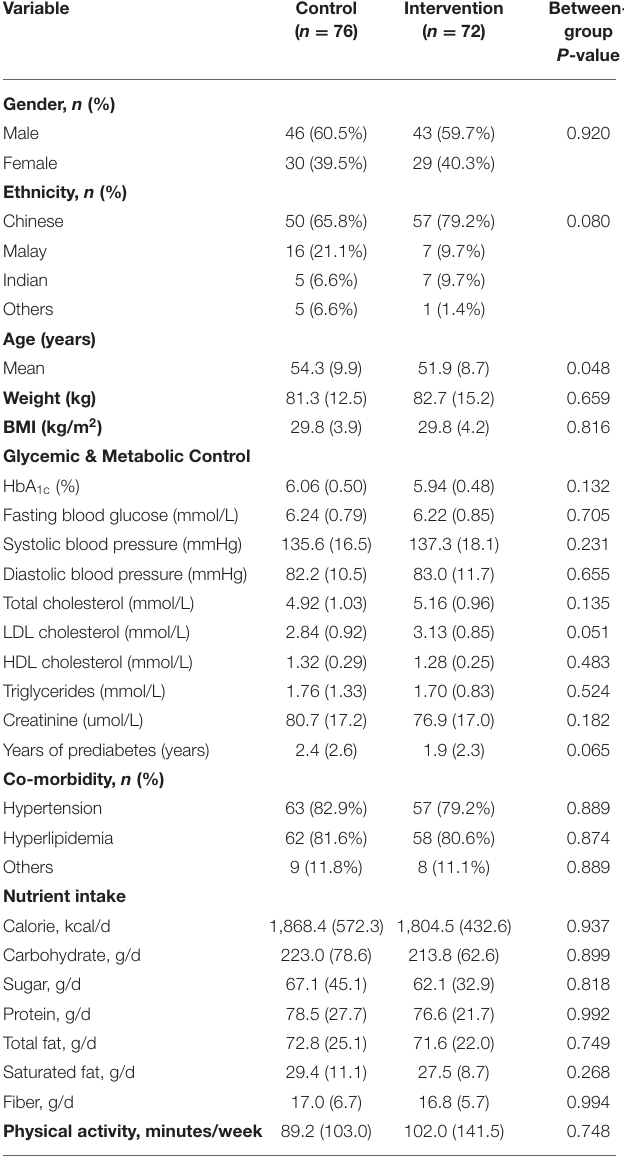
TABLE 1 | Baseline characteristics of study participants. Variable Control